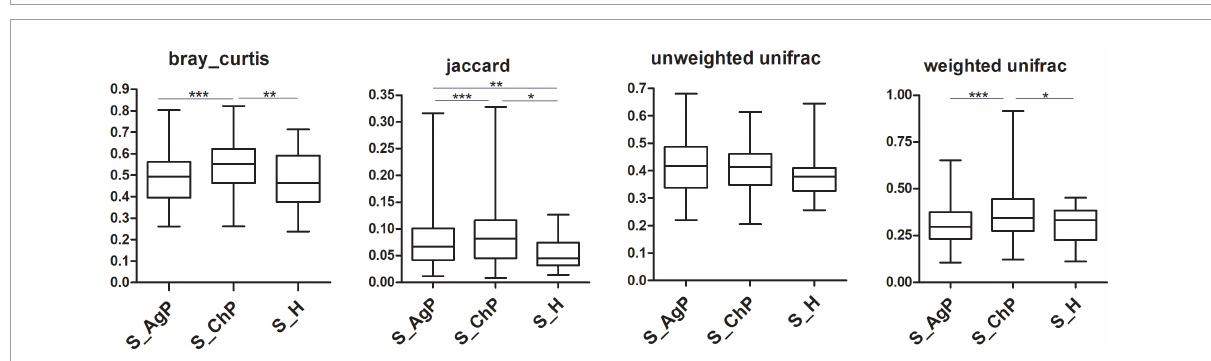
FIGURE3 Beta diversity of saliva samples in three groups based on Bray-Curtis, Jaccard, weighted, and unweighted UniFrac distances. * p < 0.05; ** p < 0.01; *** p <